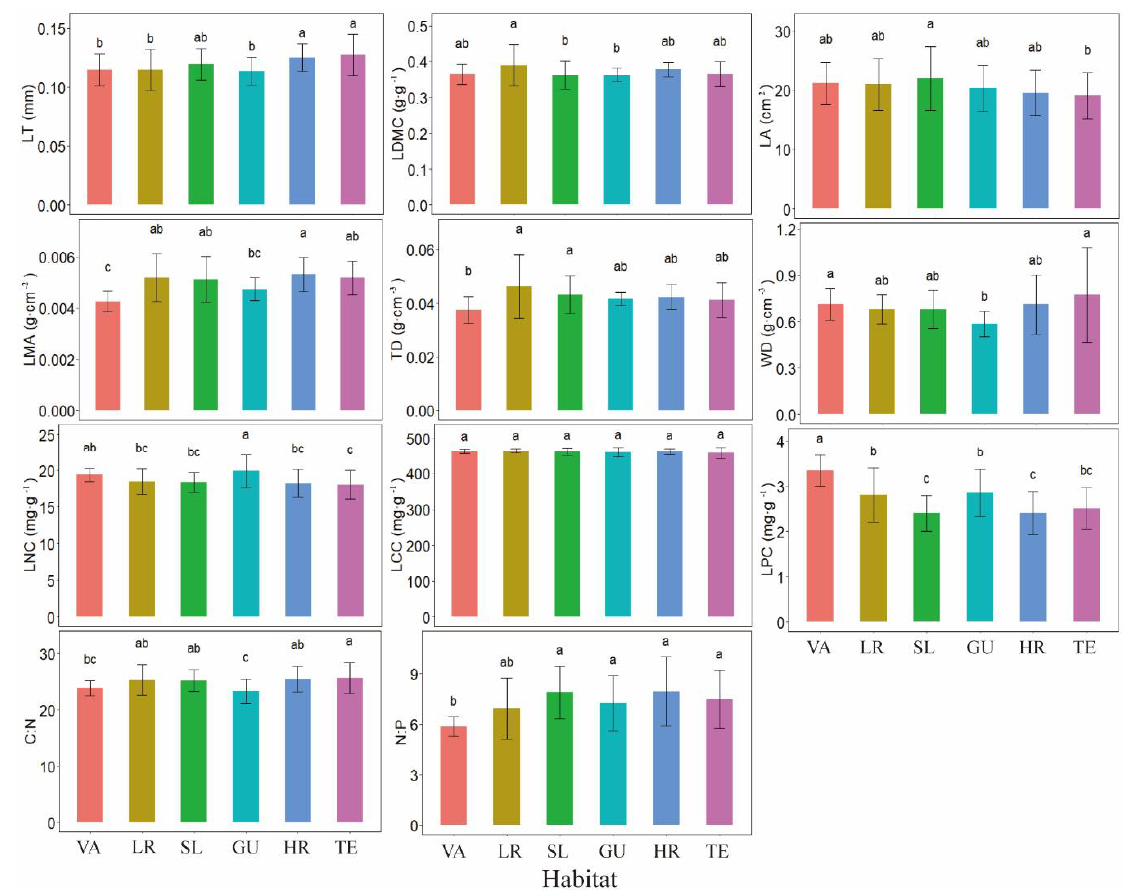
Figure 2. Changes in functional traits of L. fragrantissima var. lancifolia across habitats. Error bars represent the standard error. a is the largest, followed by b, and c is the smallest. Different letters denote significant differences among different habitats at p < 0.05. Habitat abbreviations: VA (valley);